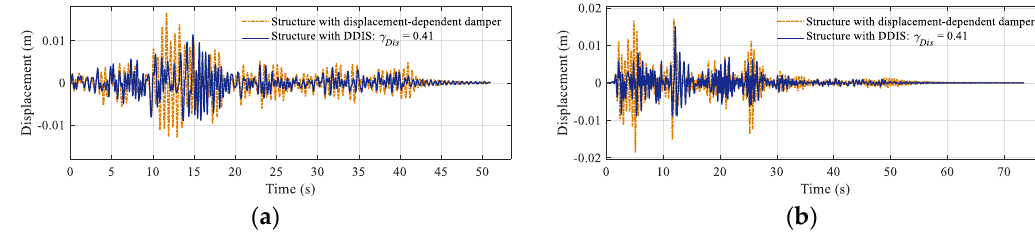
Figure 15. Displacement responses of structures fitted with the DDIS and displacement-dependent damper under ( a ) El Centro and ( b ) SS excitation.